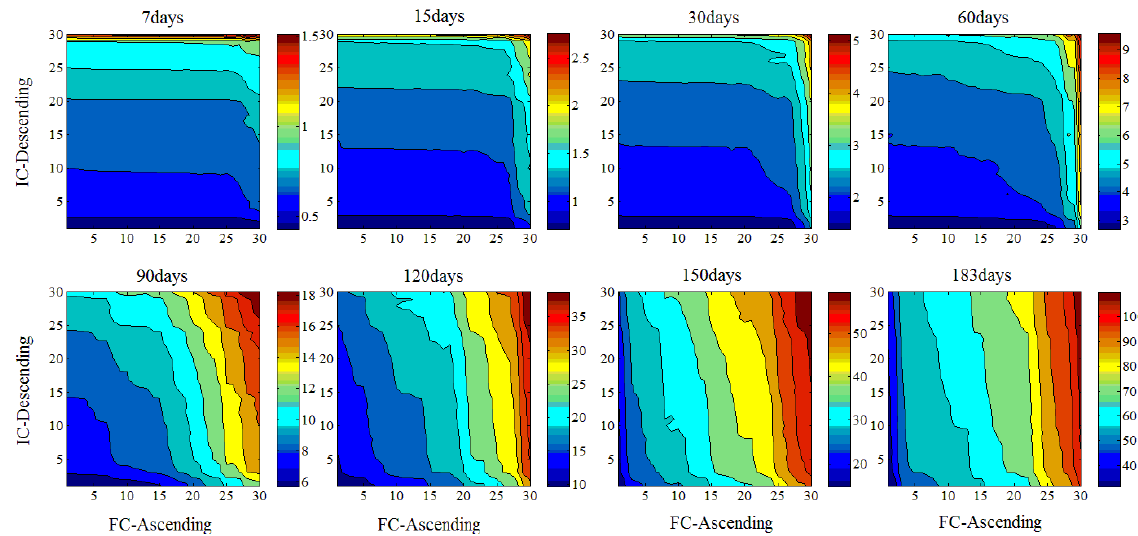
Fig. 6. Runoff forecasts (unit: mm) by ESP (row) and R-ESP (column) for UHRB. Forecasts are initialized on 1 February. Precipitation forcing (units: mm) is sorted from dry to wet in ascending order, and Initial conditions (units: mm) is sorted from wet to dry in descending order. The numbers on the horizontal and vertical axis represent the ranks of actual accumulated precipitation and soil moisture, respectively.